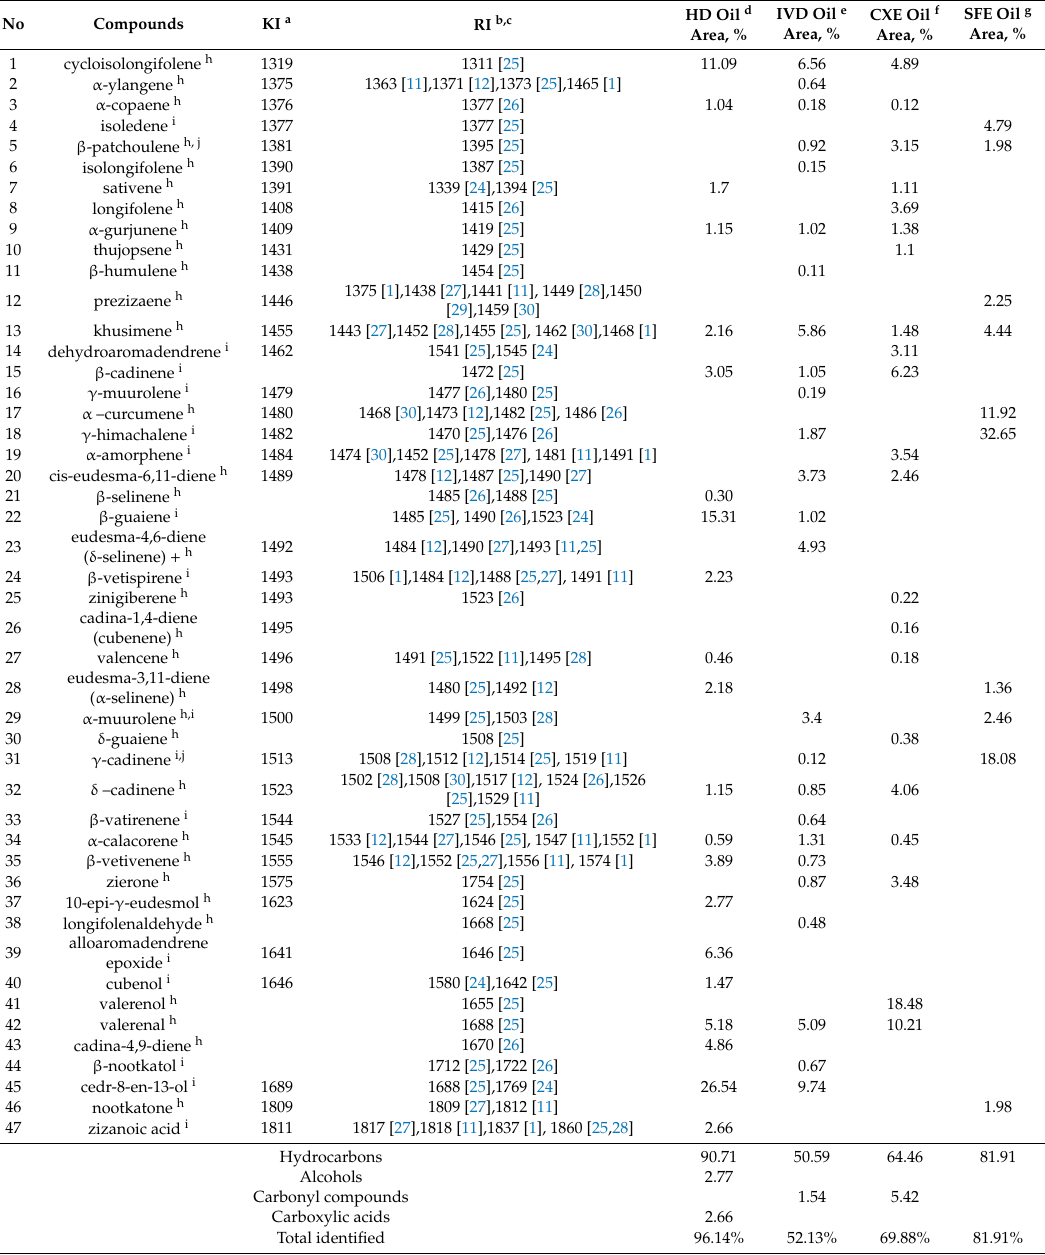
Table 1. Identification of chemical components in vetiver essential